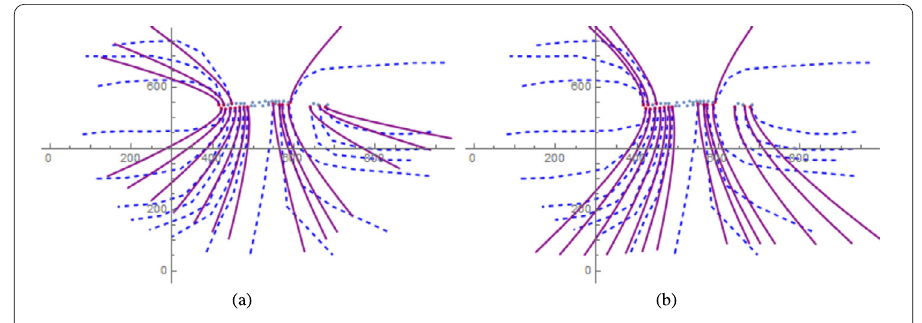
Figure 13 Similarity between the whole reconstructed tunnel (solid line) with default configurations in Fig. 11 and the whole real tunnel (dashed line). ( a ) With consideration of the ID hypothesis; ( b ) without consideration of the ID hypothesis